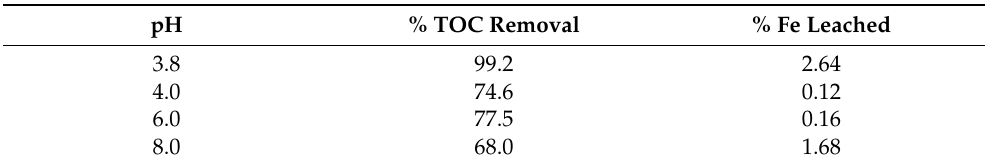
Table 3. Effect of pH on PhCatOz final mineralization values and Fe leaching detected with FeGOTi. Conditions: gas flow rate, 35 L h − 1 ; inlet ozone gas concentration, 10 mg L − 1 ; primidone, C 0 = 10 mg L − 1 ;